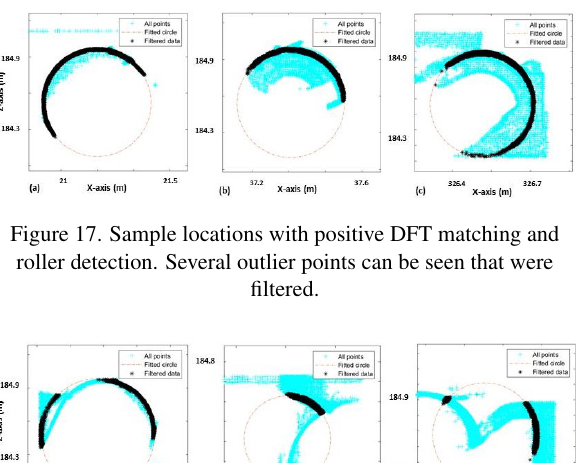
Figure 16. Mean and actual roller axis and the surface points.